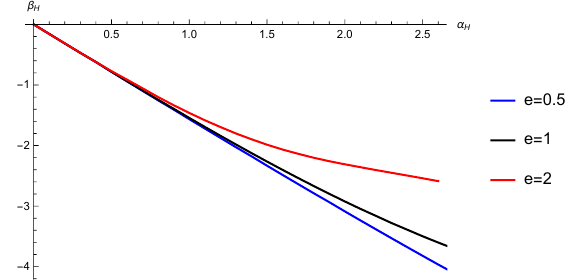
and β for different values of H H